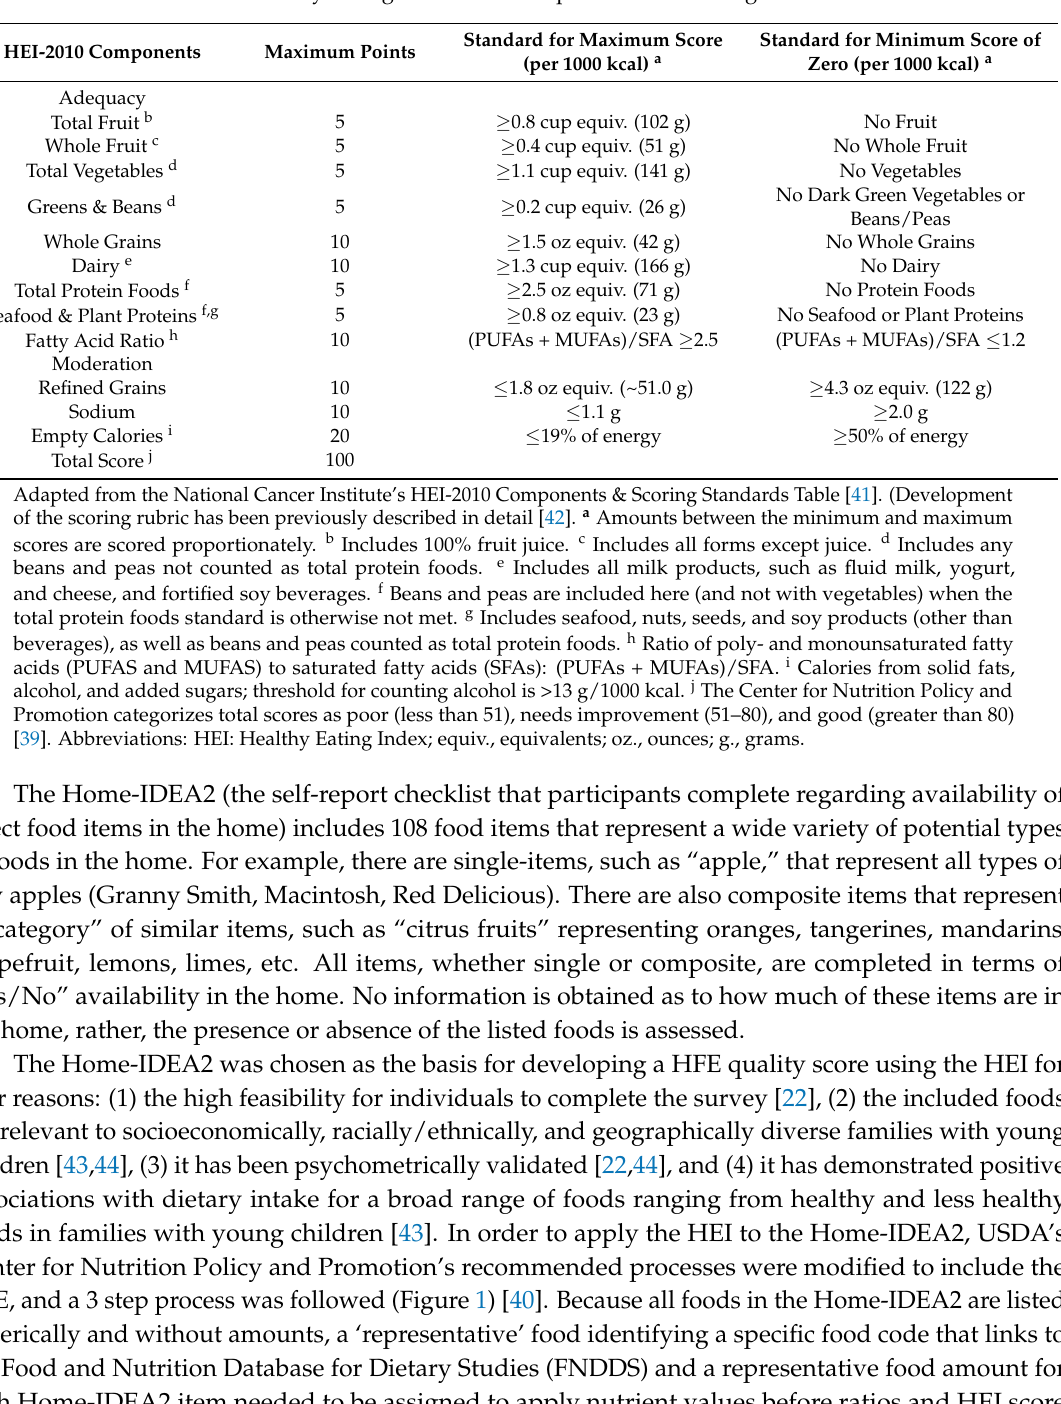
Table 1. Healthy Eating Index-2010 components and scoring